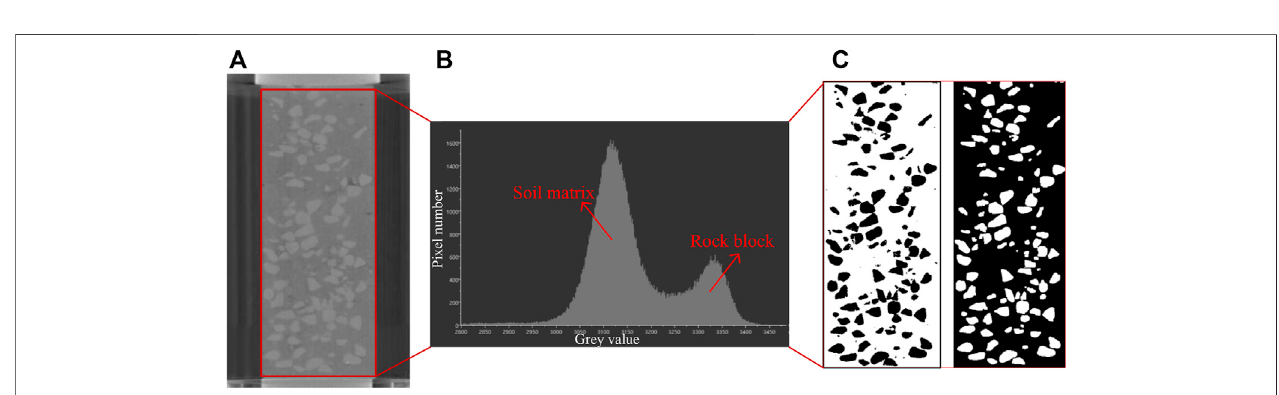
FIGURE 2 | Images of separating the rock block and soil from the vertical slices in the SRM. (A) SRM vertical CT slice. (B) Gray distribution. (C) Segmentation images of the rock (left) and soil (right), respectively.